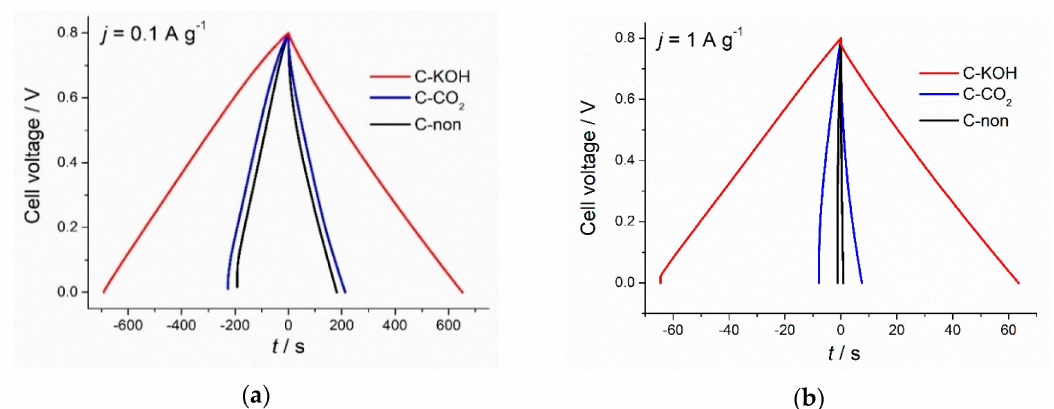
Figure 4. Charge-discharge profiles of C–KOH, C–CO 2 and C-non samples at 0.1 A g − 1 ( a ) and